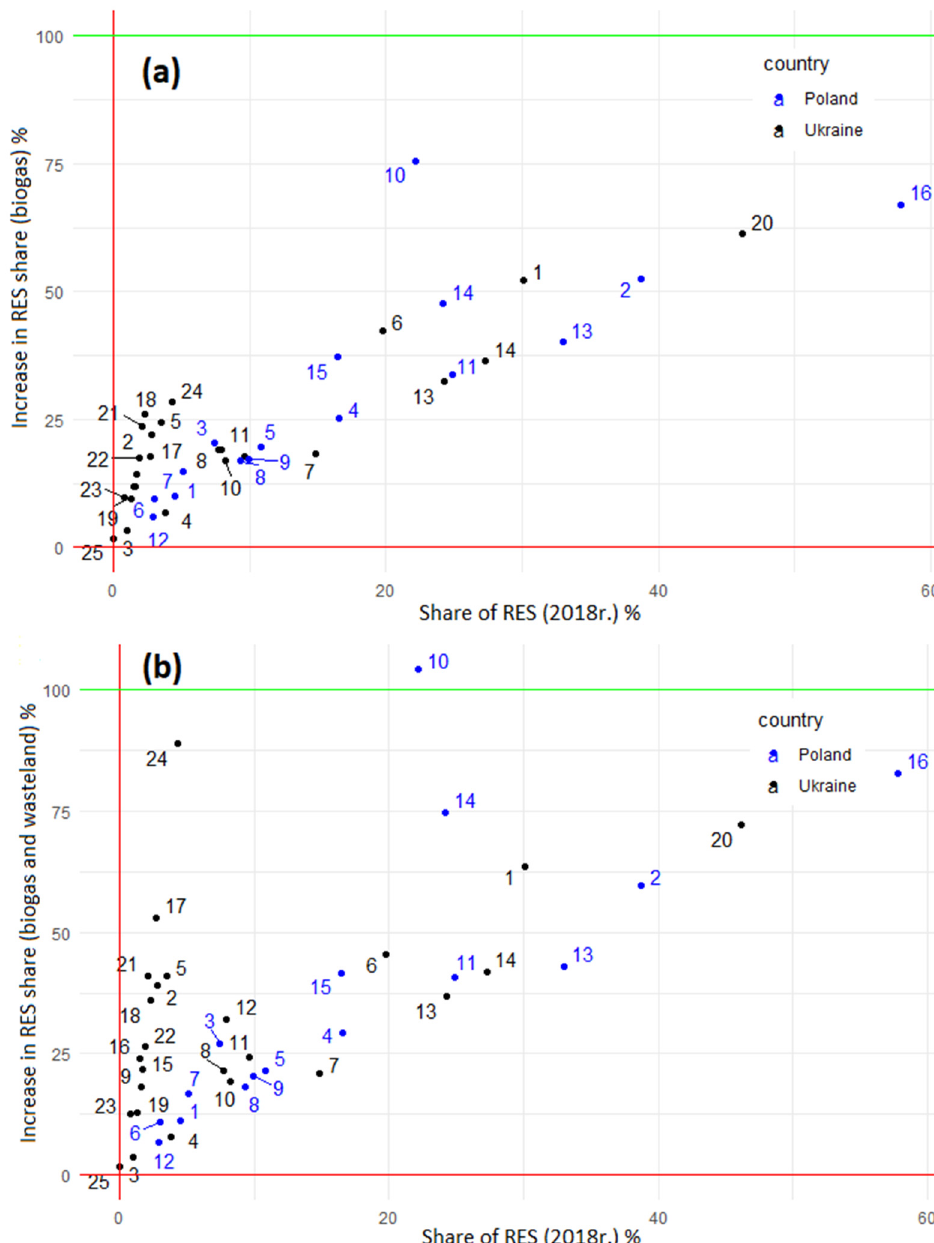
Figure 8. The impact of the basic potential of biogas ( a ) and influence of wasteland use ( b ) on the share of renewable energy sources in electricity consumption. Source: Own study.